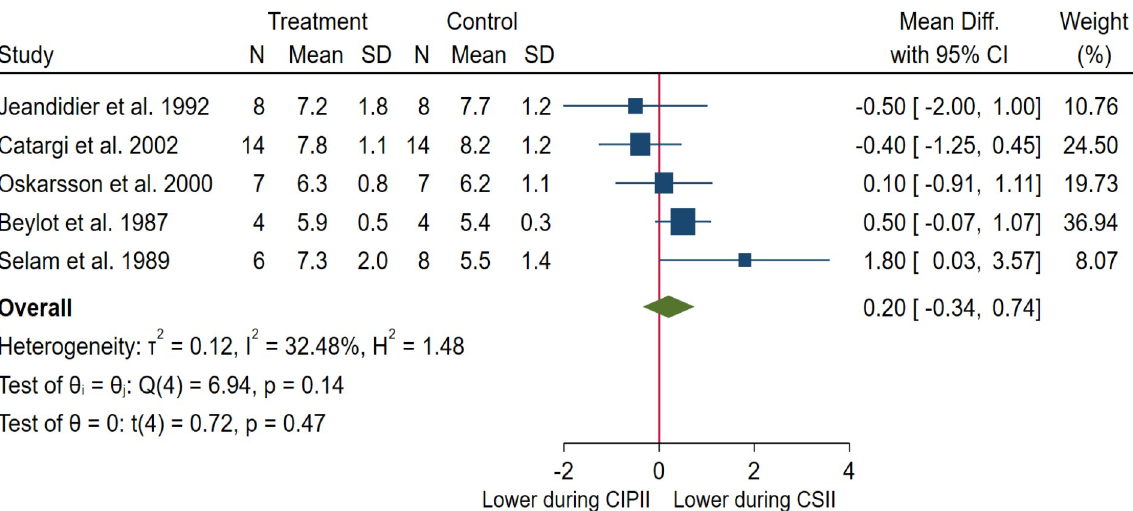
Fig 4. Meta-analysis of fasting blood glucose (mmol/L) in patients during CIPII treatment compared to that during control treatment (CSII). Treatment, continuous intraperitoneal insulin infusion (CIPII); Control, continuous subcutaneous insulin infusion (CSII). Studies are ordered by effect size (mean